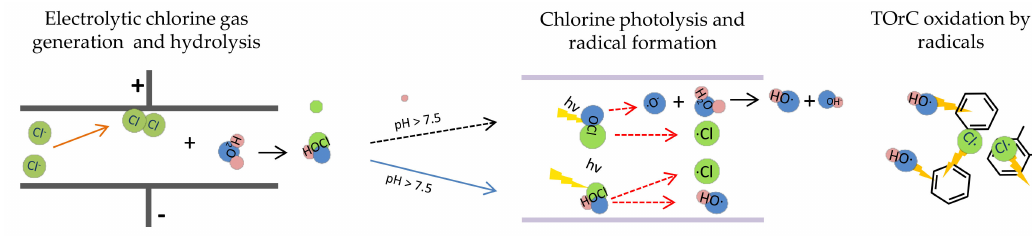
Figure 1. Pathway of chloride ions used for radical production (excerpt) in UV / ECl 2